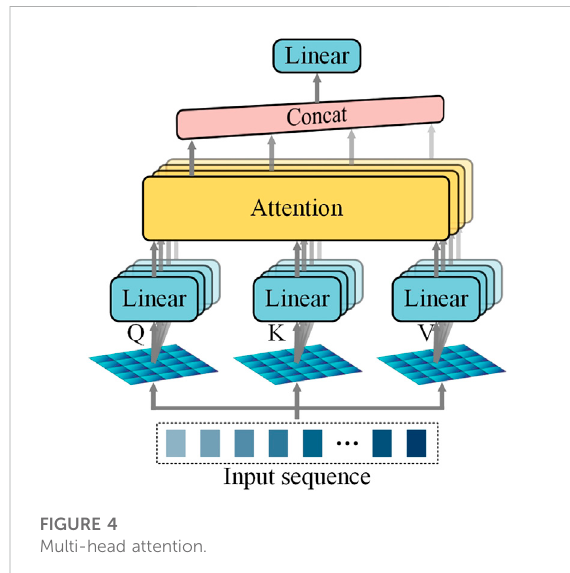
FIGURE 4 Multi-head attention.